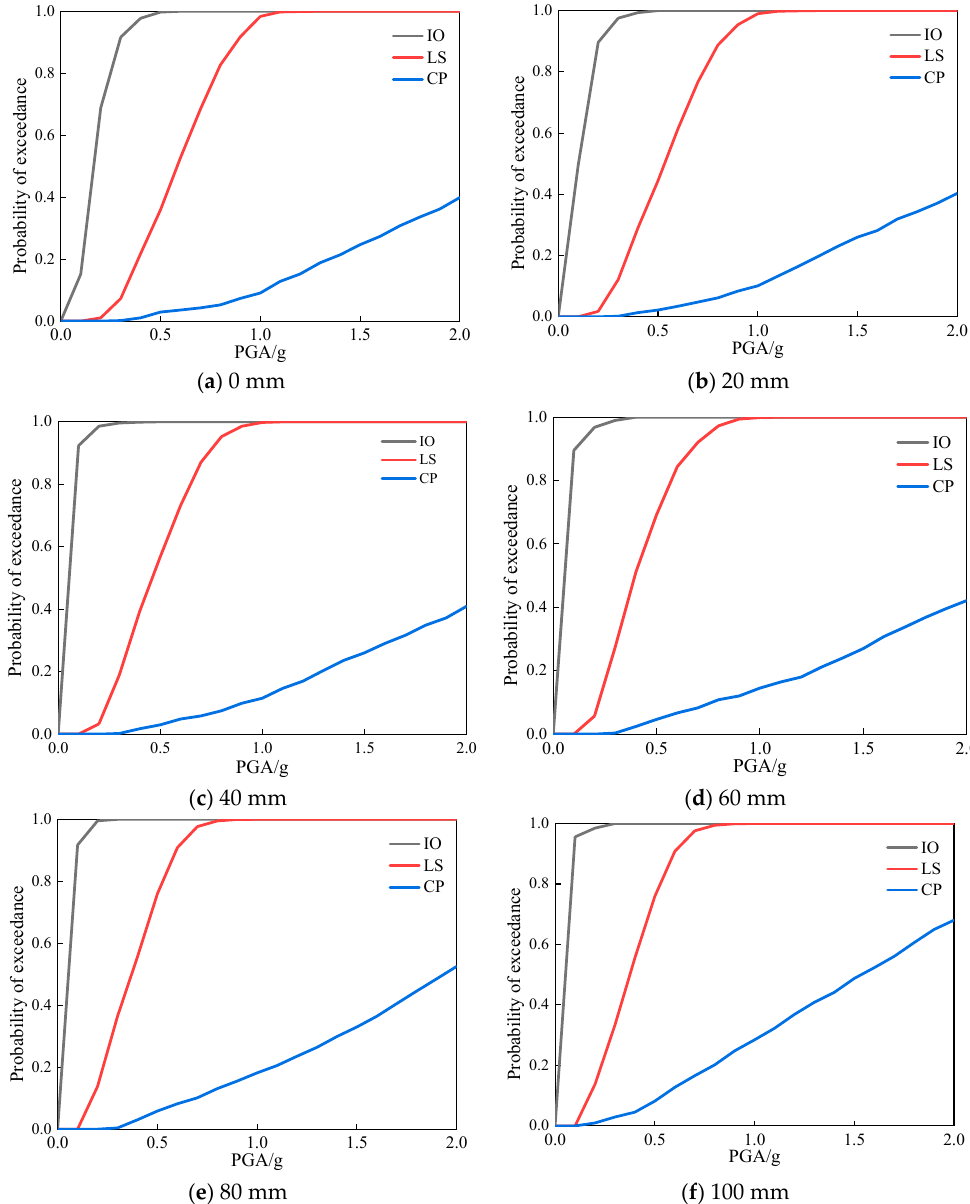
Figure 9. Fragility curves of structures with different uneven settlement quantities in Zone I.